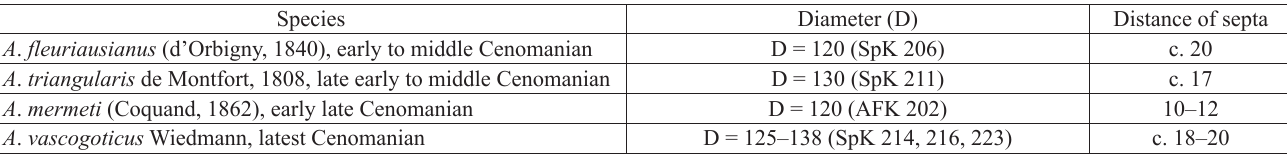
Table 3. Septal distances (in mm, measured at venter) of different Cenomanian species of Angulithes .